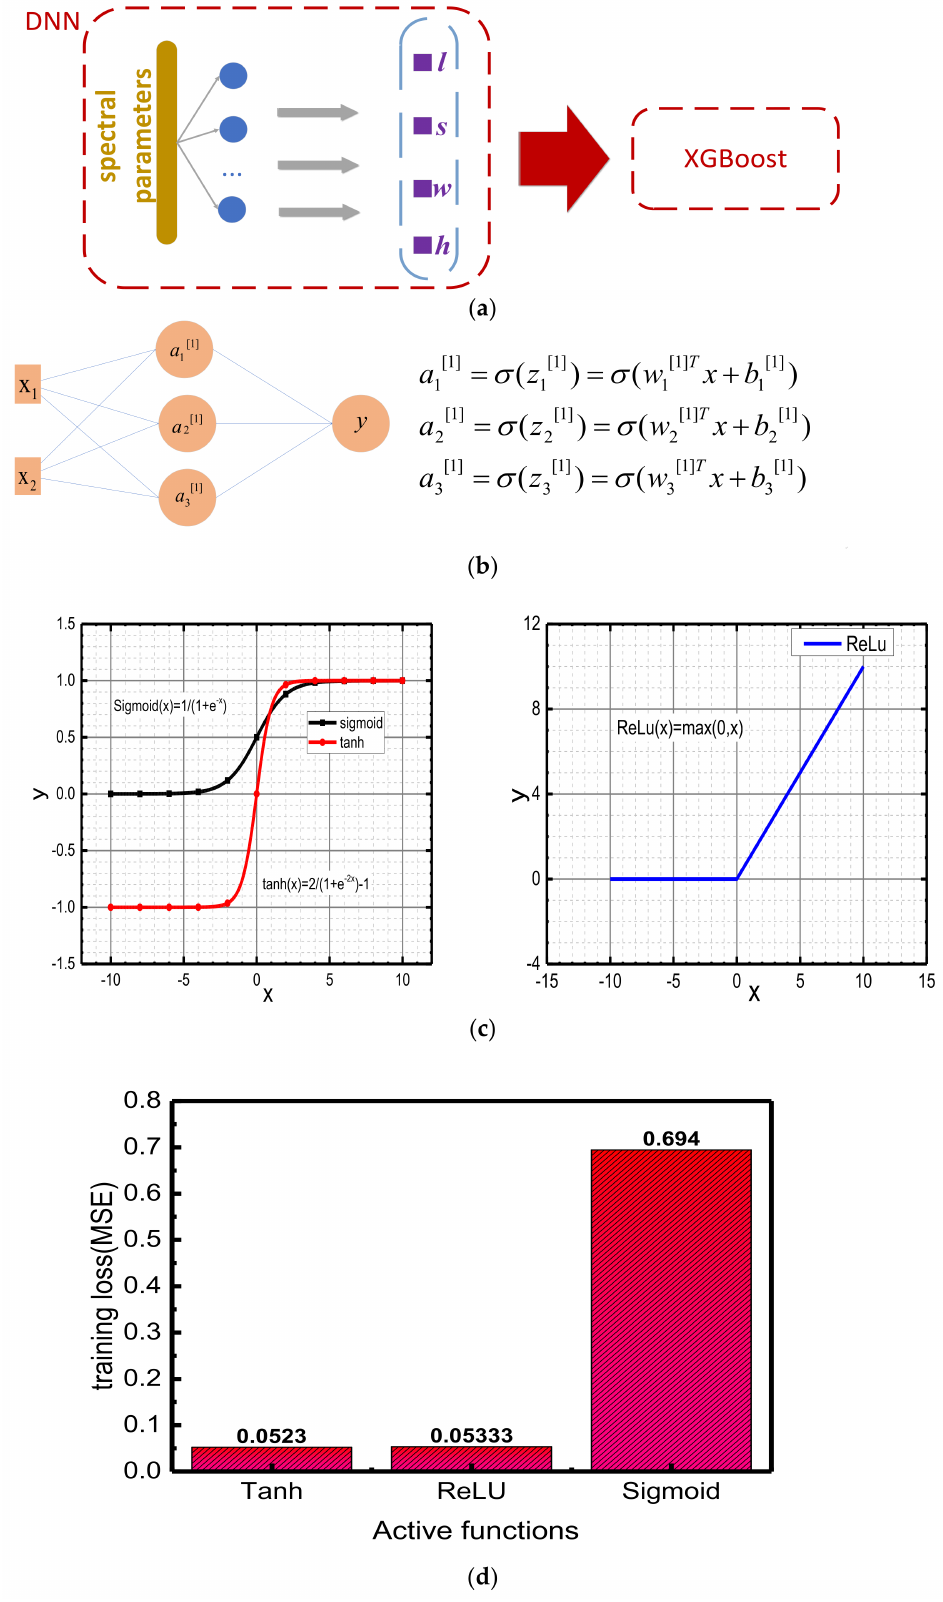
Figure 4. ( a ) XGBoost-DNN composite structure; ( b ) basic structure of a fully connected deep neural network; ( c ) three different active functions; ( d ) training loss with different active